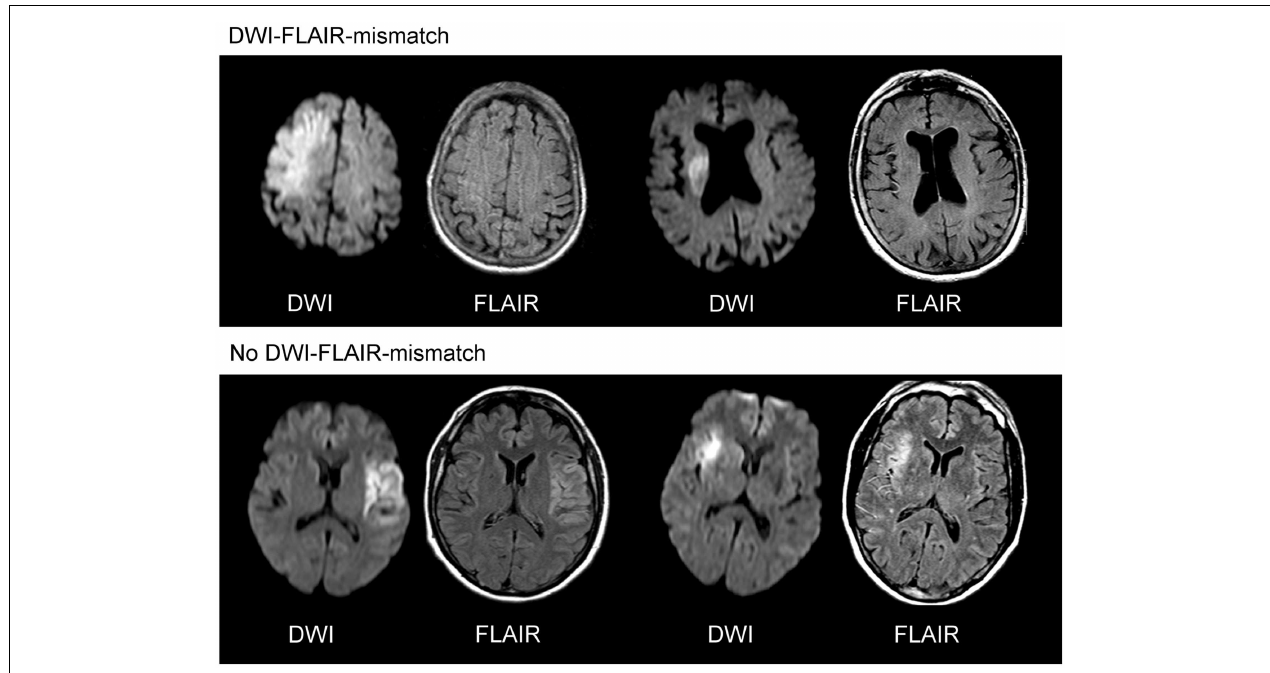
inversion recovery (FLAIR) images indicating DWI-FLAIR-mismatch. In the lower row, a clear hyperintensity can be seen on FLAIR images in the area of the acute DWI lesion (no